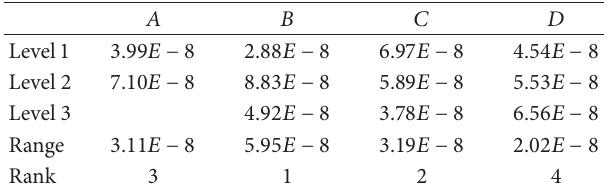
Table 2: The quality characteristic response table in 𝑋 -direction (unit: m).